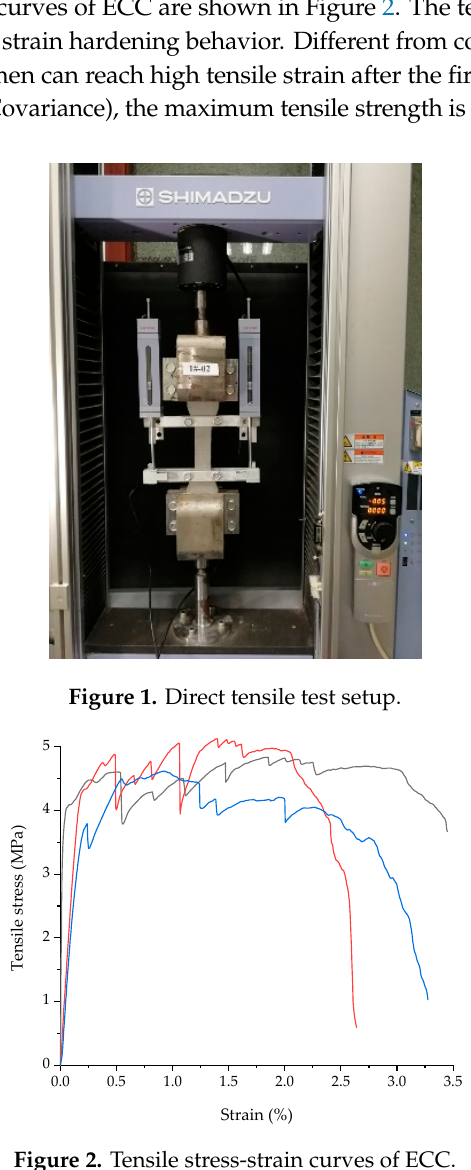
Figure 2. Tensile stress-strain curves of ECC.